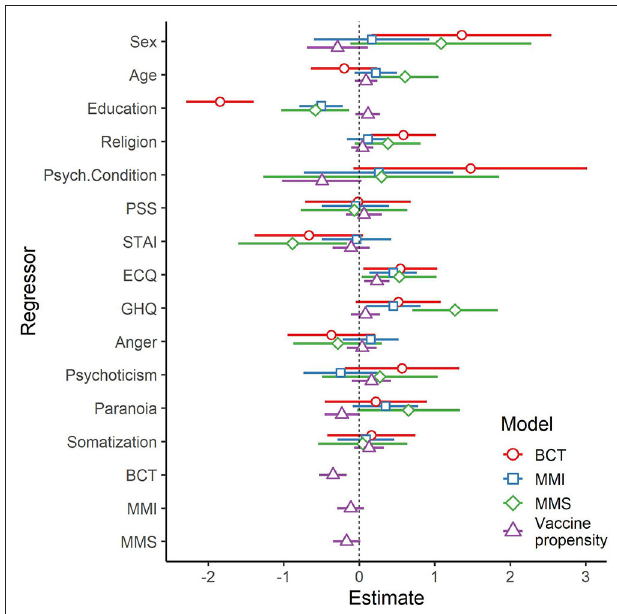
FIGURE 2 | Regression coefficients with 95% confidence intervals for the four models tested. BCT, belief in conspiracy theories; MMI, mistrust in medical information; MMS, mistrust in medicine and